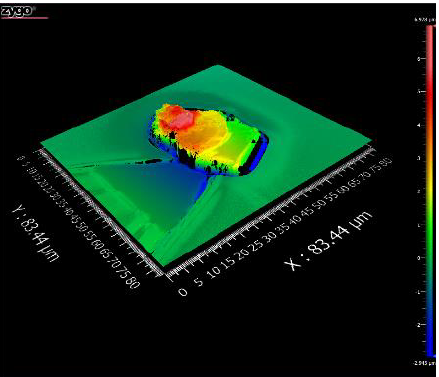
Fig.2 WLIM image and surface profile of a triangular defect on 12 μm 4H-SiC epilayer grown on 4H-SiC substrate Measurements were carried up with the microscope Zygo NewView with a 20x objective (Fig. 2). The resolution was ⁓ 1 nm in vertical and ⁓ 0,7 μm in horizontal directions. These measurements brought into light some structures in the 4H-SiC epilayer, which were not visible by imaging ellipsometry.